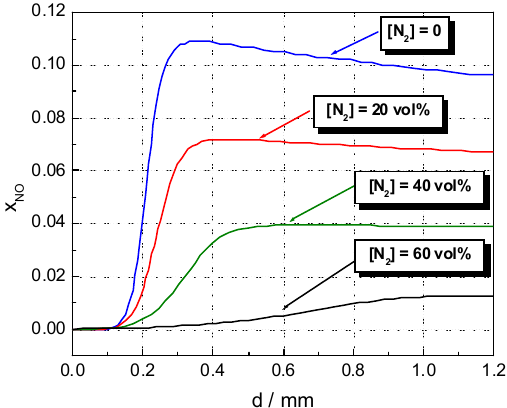
Figure 3. NO mass fraction profiles of the flame front of N 2 -diluted stoichiometric H 2 –N 2 O flames with various nitrogen concentrations under ambient initial conditions.